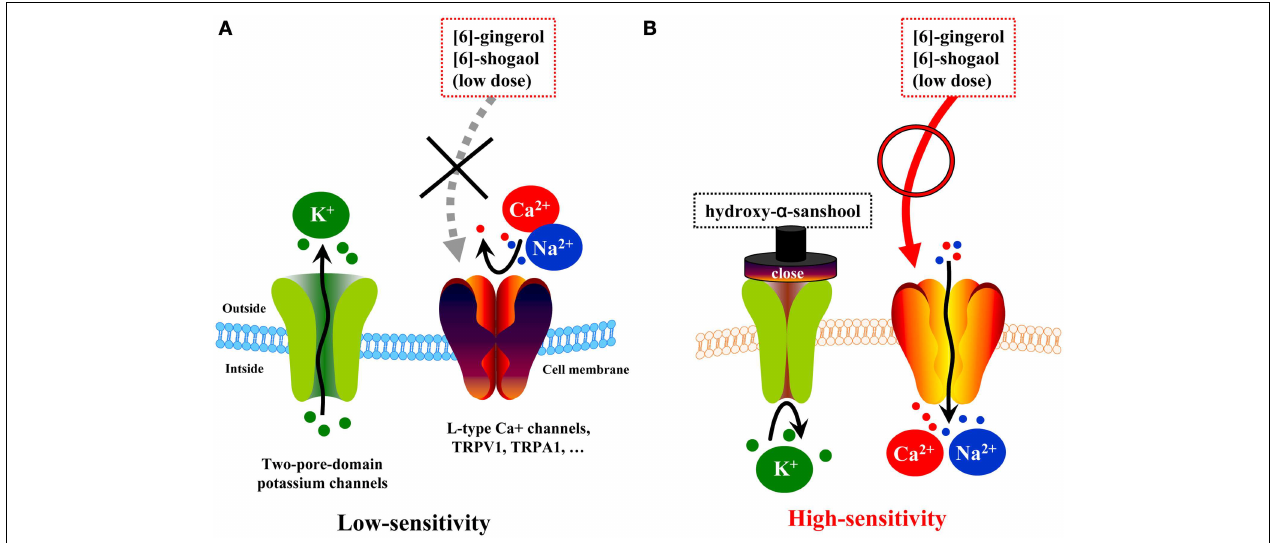
of ginger compounds cannot evoke action potentials. (B) One of compounds of daikenchuto, hydroxy- α -sanshool, acts as a blocker of two-pore-domain potassium leak channels (KCNK3 and KCNK9) and alters the excitability of a cell via voltage-activated cation channels. Low doses of ginger compounds can evoke action